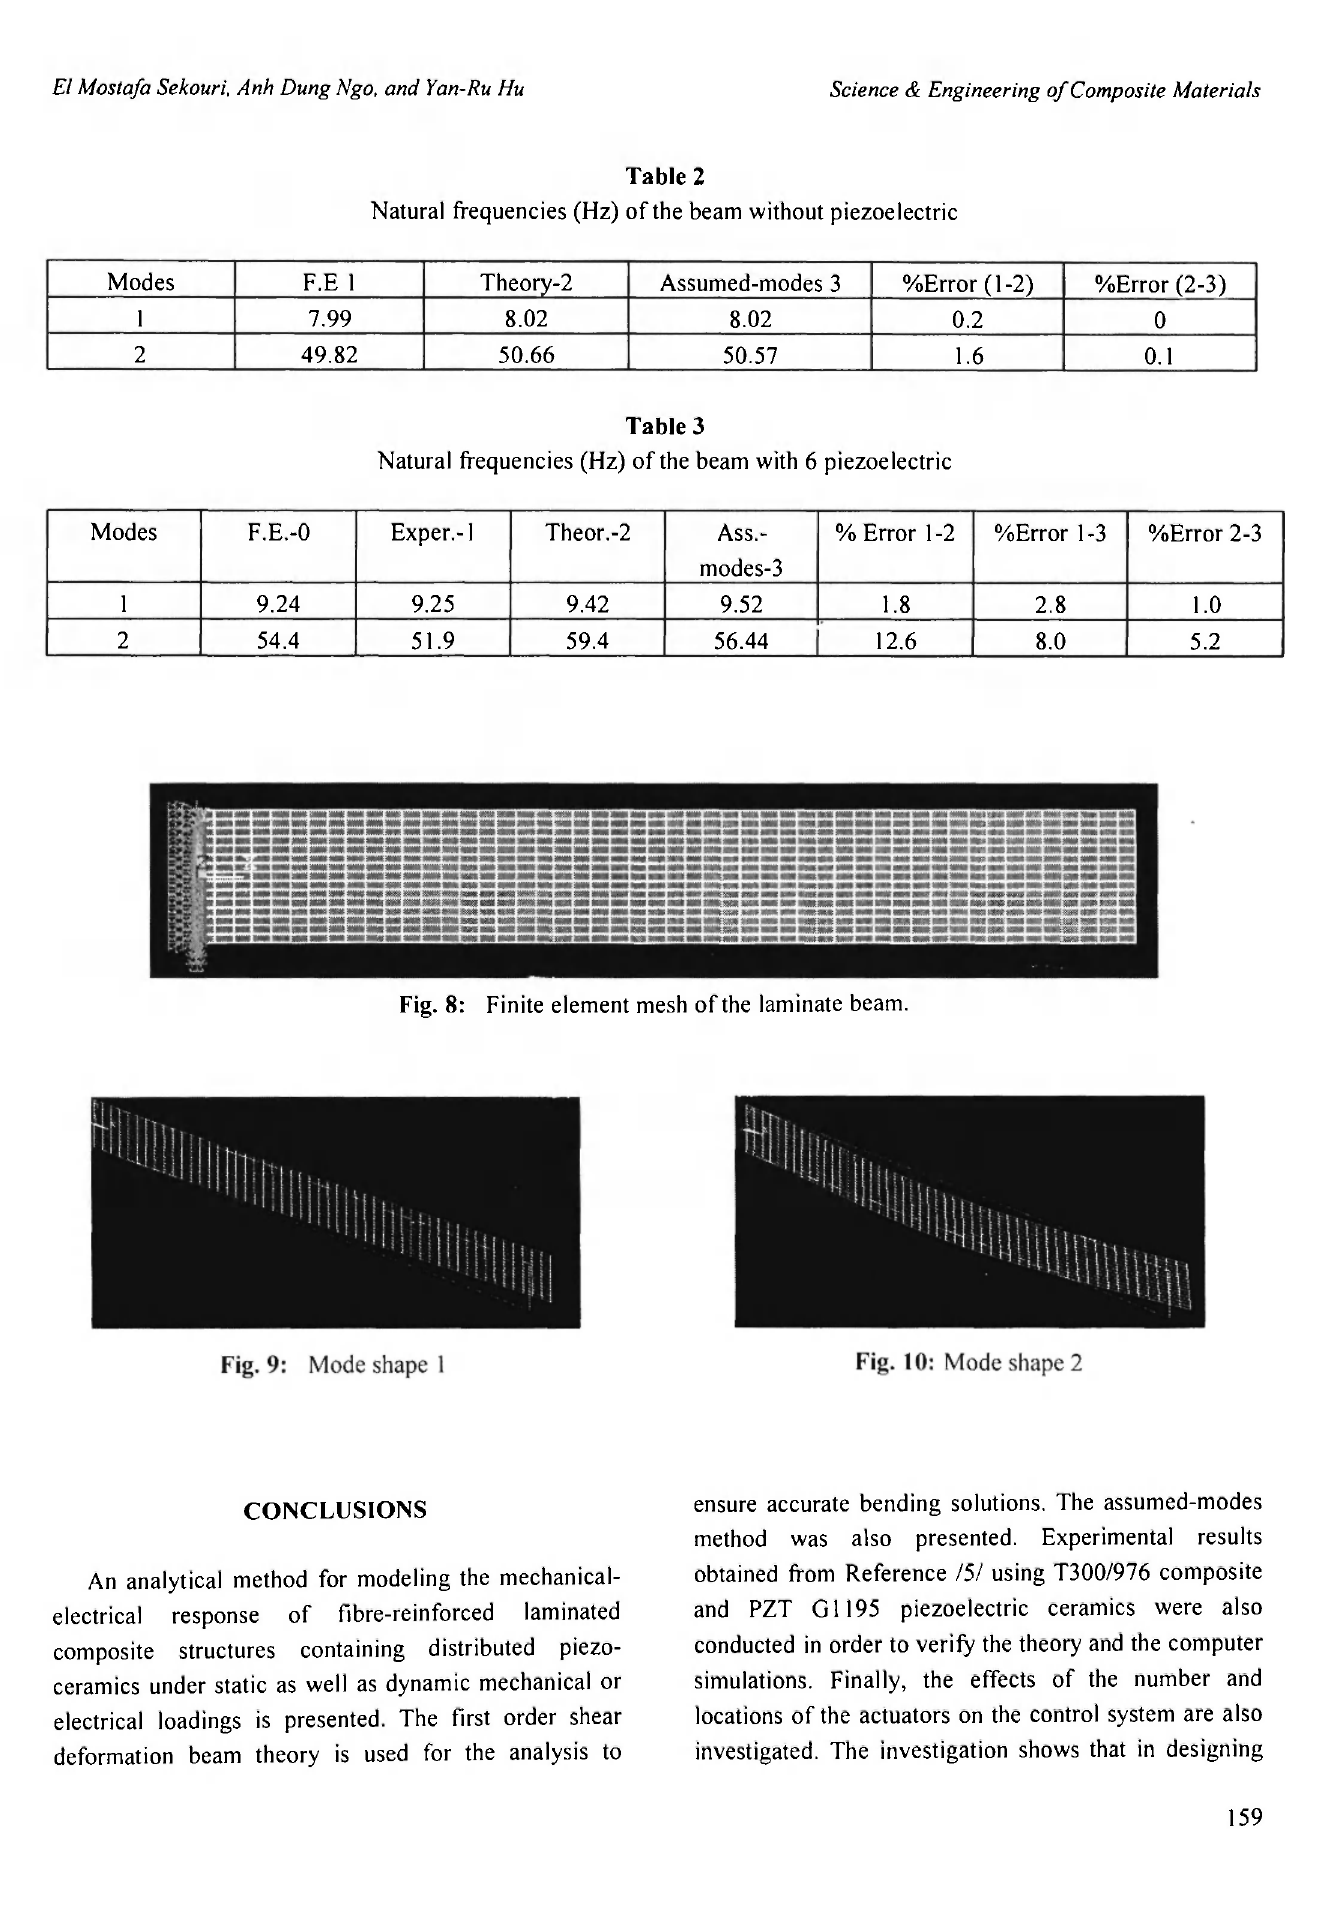
Fig. 8: Finite element mesh of the laminate